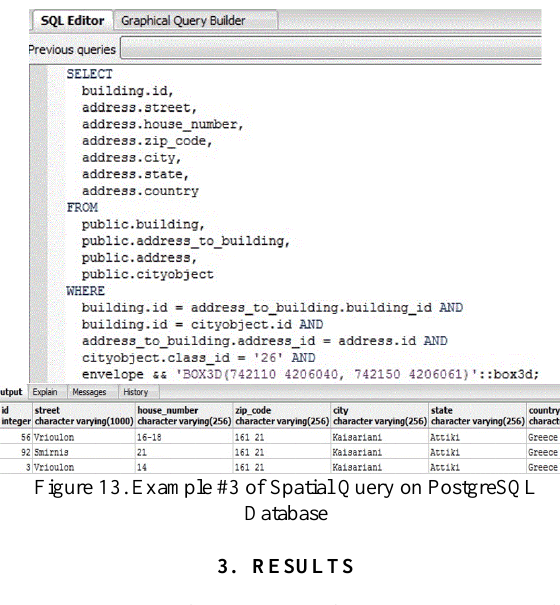
Figure 13. Example #3 of Spatial Query on PostgreSQL Database